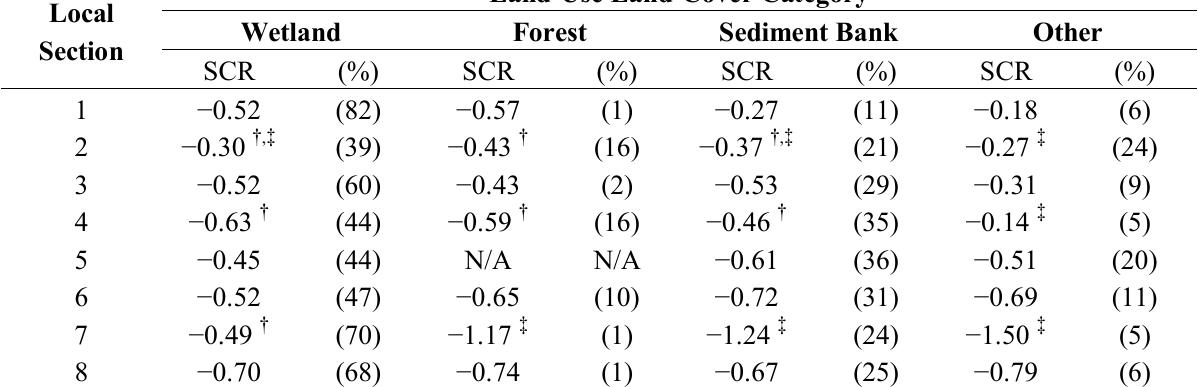
Table 4. Mean shoreline-change rate (SCR) and percent (%) of the LULC categories for each Local Section. Significantly different values of SCR are denoted by different